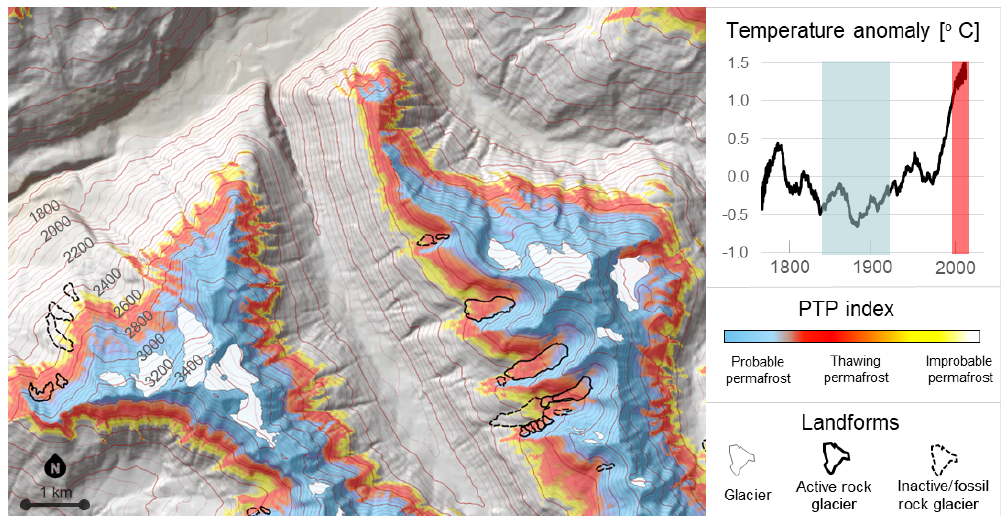
Figure 5. Map of potential thawing permafrost (PTP) distribution in the Mont Cenis range, indicating the extent of the permafrost zone not in equilibrium with the present climate (red coloured areas). Temperature warming to compute the map is evaluated using HISTALP data (Auer et al., 2007) between the end of the Little Ice Age (light blue shaded period in the temperature anomaly plot) and the current climate (red shaded